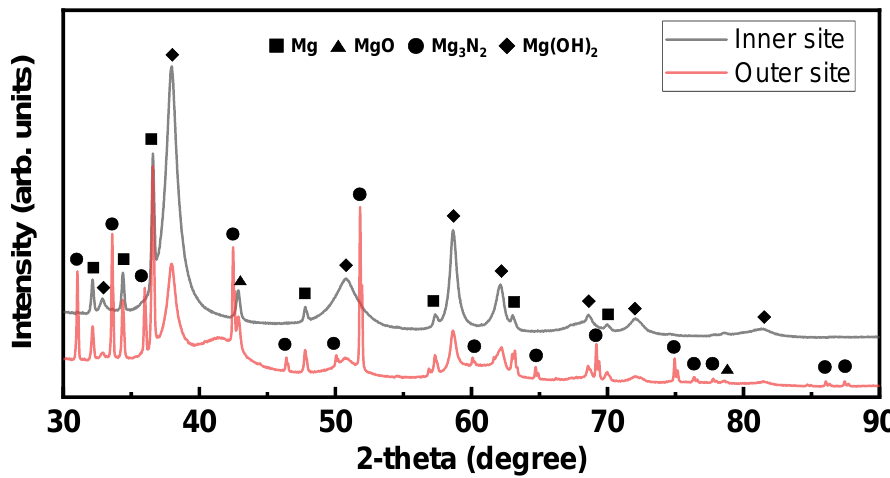
Figure 18. XRD diffraction pattern of magnesium combustion’s by-products. Indexed according to JCPDS cards: 00-035-0821 (magnesium), 01-084-2164 (magnesium hydroxide), 01-071-2640 (magnesium nitride), and 00-004-0829 (magnesium oxide).